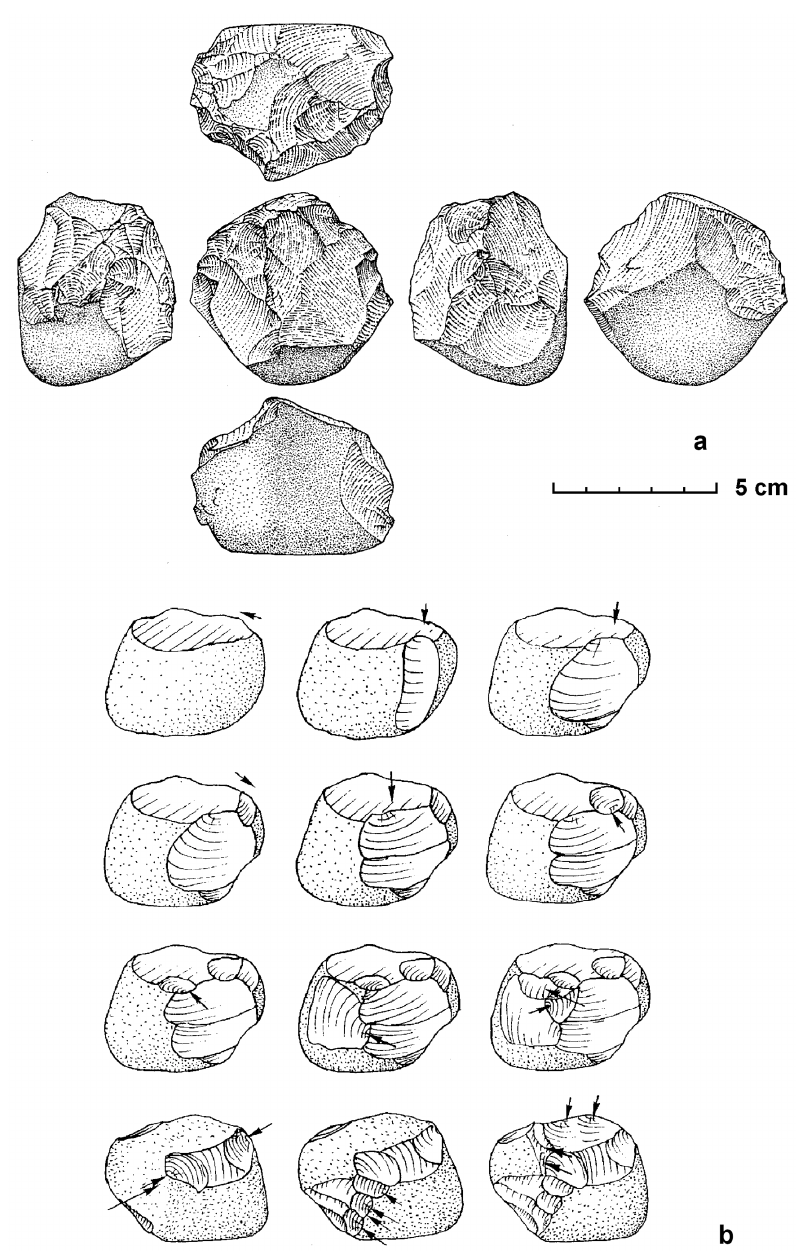
Figure 14. Dorn-Dürkheim 3. ( a ) Polyhedron (quartzite); ( b ) stages of its manufacturing. (Redrawn after Fiedler and Franzen 2002).